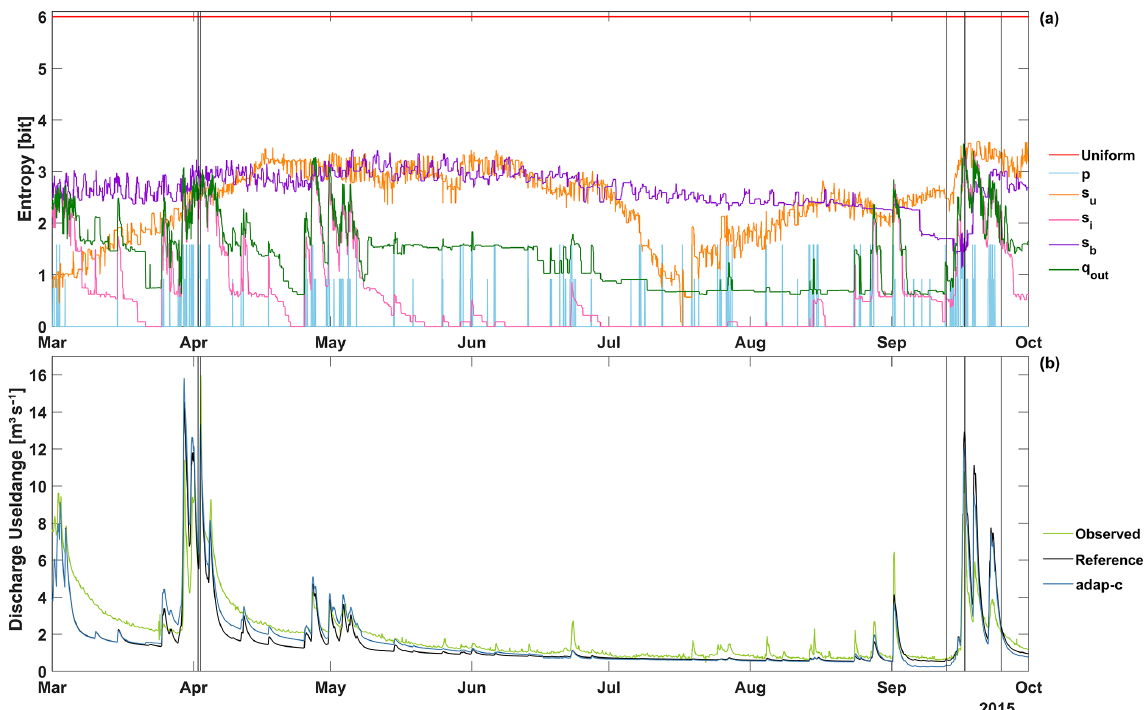
Figure 3. (a) Time series of Shannon entropy of distributions of normalised and binned subcatchment states and fluxes. Distributions are based on the fully distributed reference model run. P – precipitation, s u – unsaturated zone storage, s i – interflow, s b – base flow storage, and q out – subcatchment runoff (see Fig. A1 and Table A1). The term “uniform” indicates the benchmark maximum entropy of 6bit for a 64 bin distribution. Black vertical lines indicate times for which spatial maps are shown in Fig. 4. (b) Discharge time series at the catchment outlet at the Useldange gauge. Observed – observations, reference – results from the fully distributed reference model run, and adap-c – from an adaptive clustering run with optimised parameters, as shown in Table